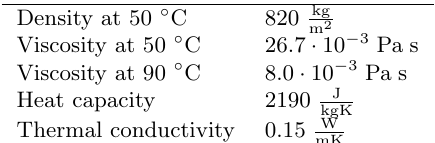
Table 4: Lubricant properties for synthetic oil ISO VG 46 of poly- α -olefin type (Glavatskikh, 2000; Glavatskikh and Larsson, 2000).